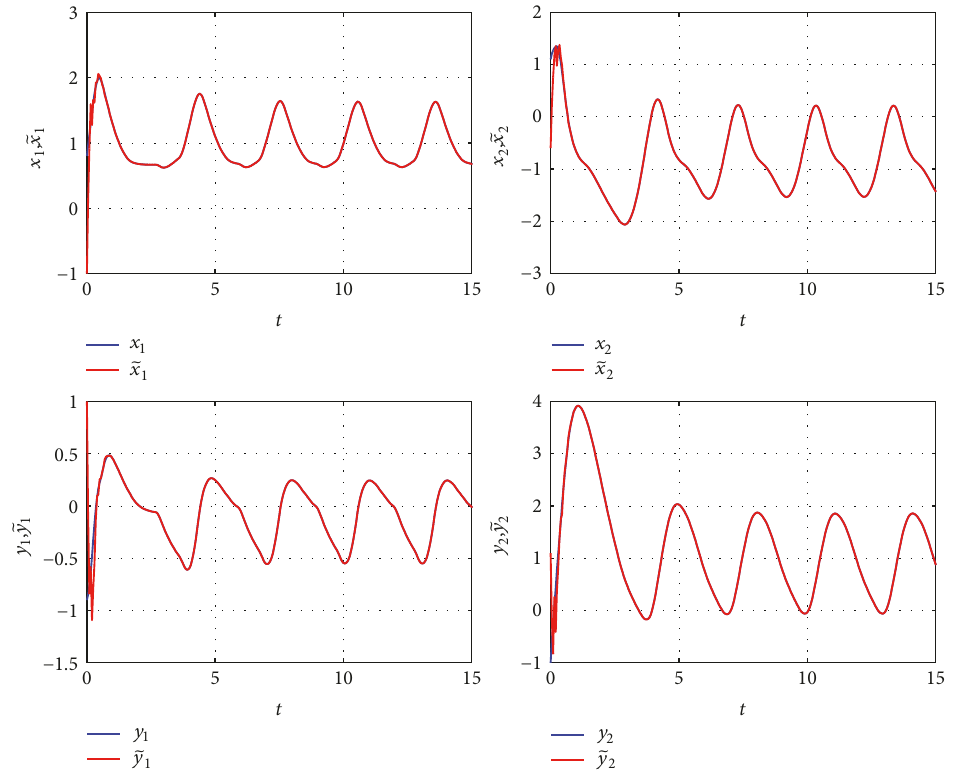
Figure 7: Synchronization curves of real and imaginary parts of 𝑧 1 , 𝑧 2 , ̃𝑧 1 , and ̃𝑧 2 under controller for example